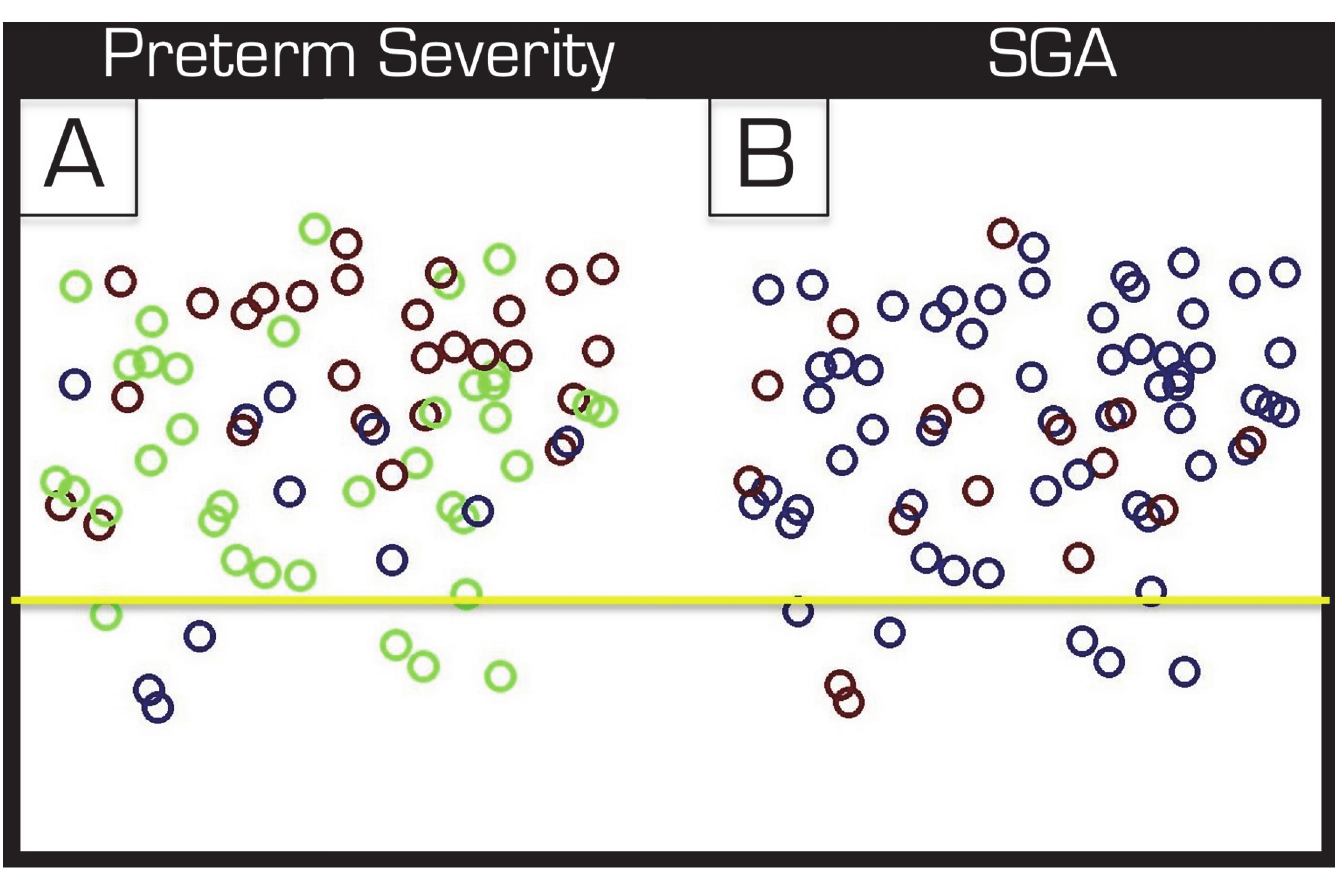
Fig 4. Effect of extent of preterm birth and SGA birth on results. The group of 74 participants that were born preterm is represented by colored circles. The vertical distance from the horizontal yellow line represents the distance to decision boundary. The further above the line is more like preterm whereas further below the line is more like control. In part A the color code represents the 11 moderately preterm (blue), 36 very preterm (green) and 27 extremely preterm (red) births based on gestational age. In part B the 16 individuals that were born SGA are represented by red circles while the other 58 by blue